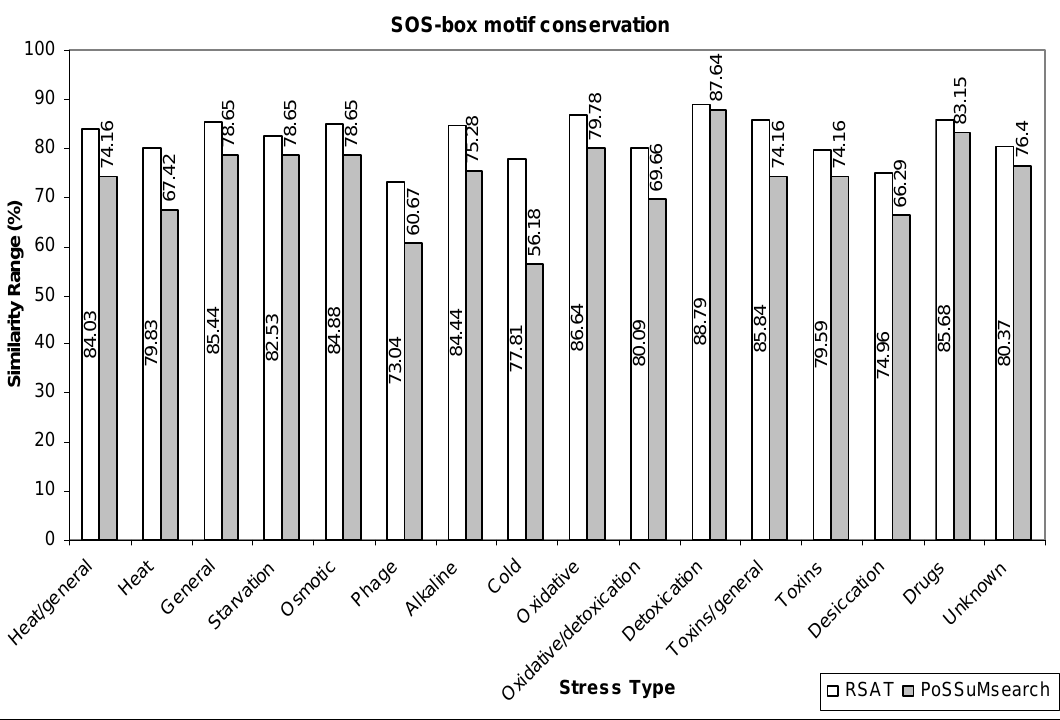
Figure 2: Graphical representation of comparative SOS-box motif conservation (only max. %) predicted through both RSAT & PoSSuMsearch programs in D. radiodurans genes related to different stress